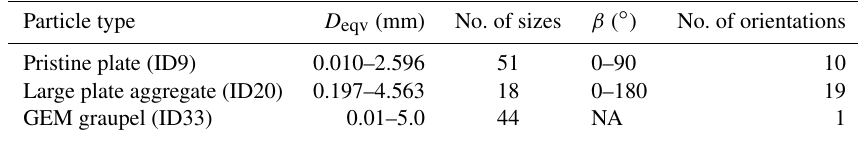
Table 2. Properties of the ARTS scattering database calculations used herein.